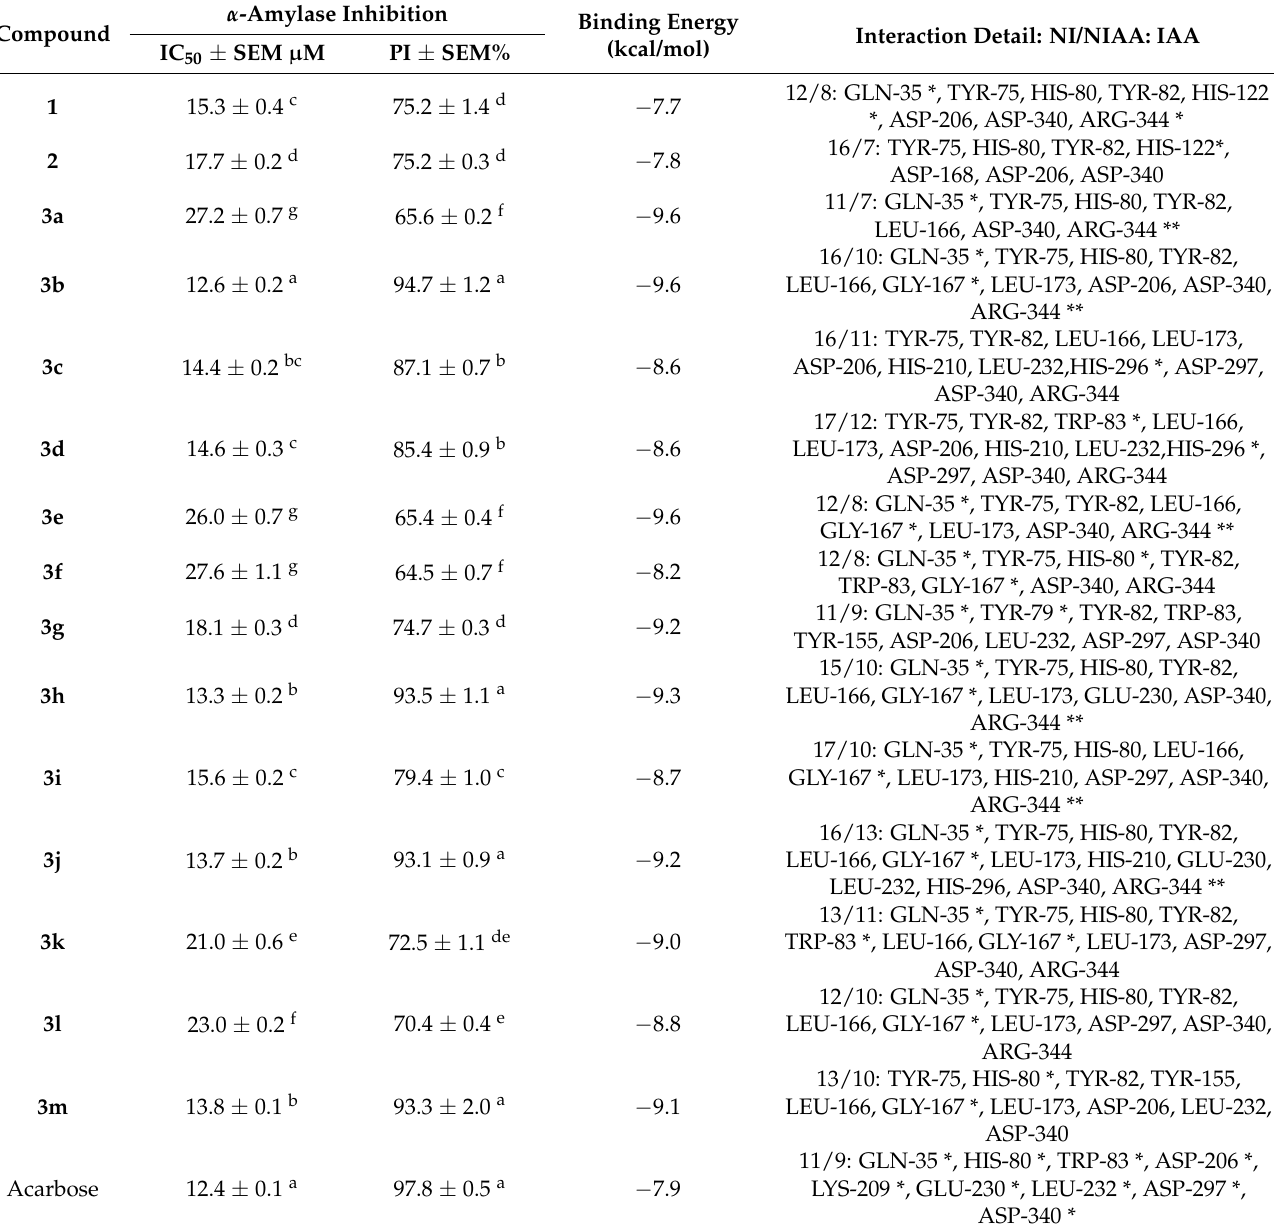
Table 2. α -Amylase inhibition potency (IC 50 ± SEM µ M) and efficacy (PI at 50 µ M), binding energy (kcal/mol), and interaction detail of compounds 1 , 2 , and 3a – m docked in the active site of the α -amylase enzyme (PDB: 7TAA).